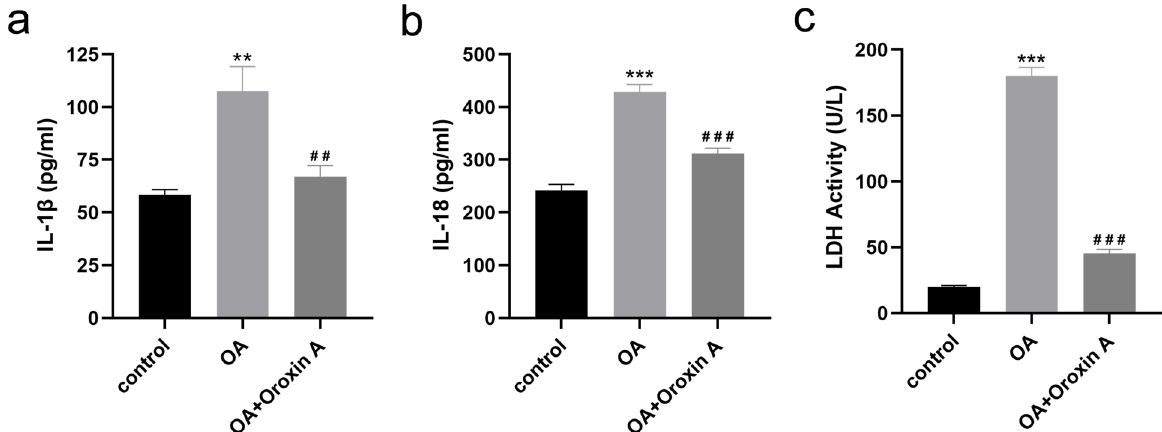
Figure 3. The effect of Oroxin A on the expression of SPC in OA-induced A549 cell injury. The level of SPC in the OA group was significantly lower than that in the control group, but the level of SPC in the OA+Oroxin A group was significantly higher than that in the OA group (a-c). All data were expressed as mean ± SEM. Statistical significance was analyzed by Student’s t test. ** p <0.01 compared with control group, # p <0.05, ## p <0.01 compared with OA group, n=3 in each